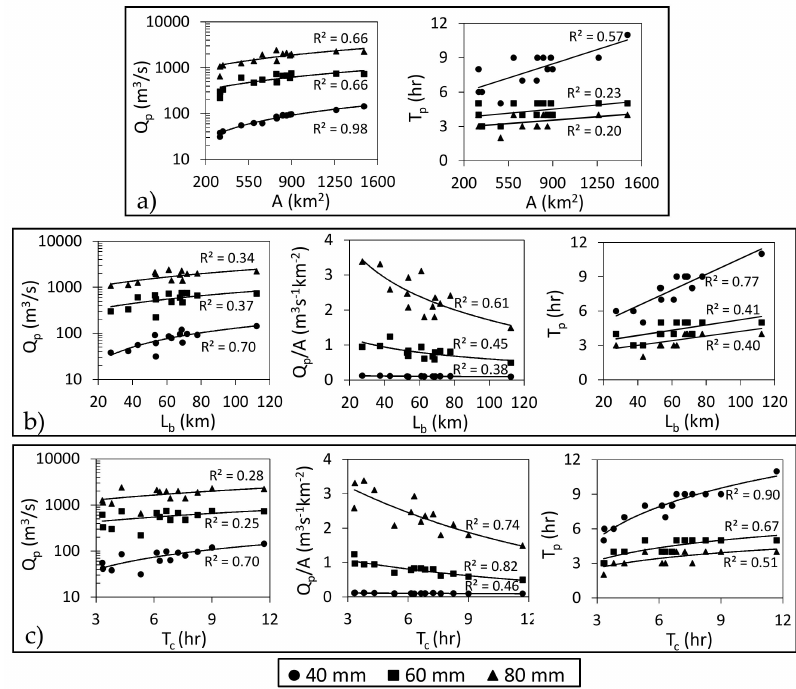
Figure 11. Relationship between the estimated hydrological indices and basin scale parameters: ( a ) area ( A ), ( b ) basin length ( L b ) and ( c ) time of concentration ( T c ) for the different applied storm intensities at all